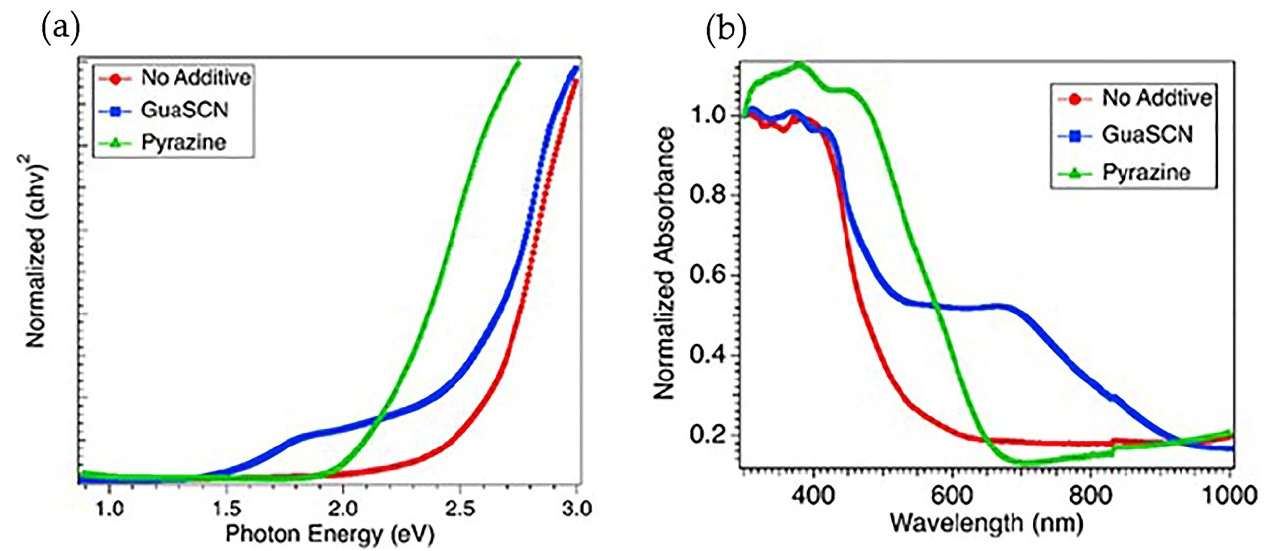
Figure 3. ( a ) Direct bandgap spectra shown in Tauc plot for GuaSCN film (blue), pyrazine added film (green), and film with no additive (red); ( b ) Uv-Vis absorption spectra for similar types of films represented in ( a ).